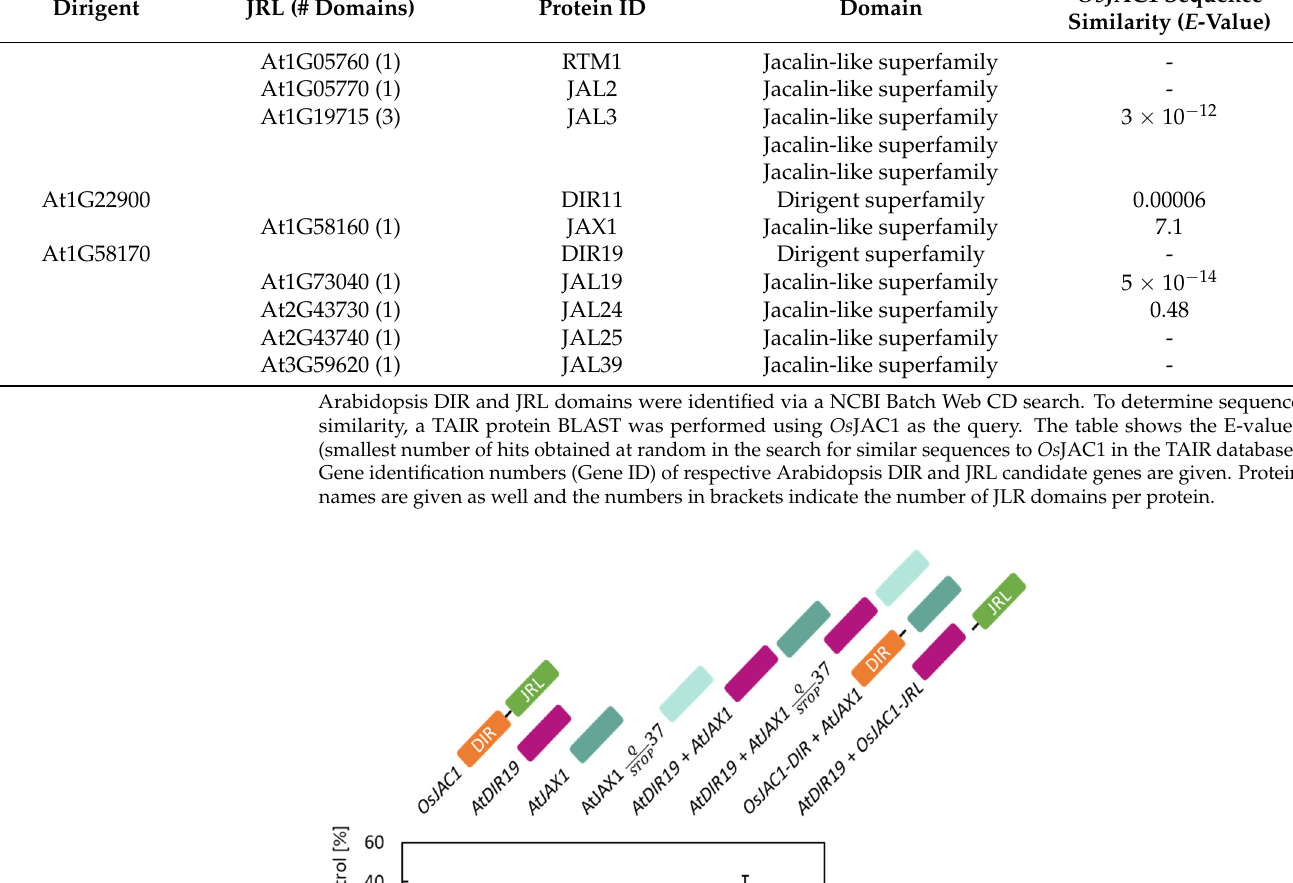
Table 1. Arabidopsis DIR and JRL candidate genes tested in this study.